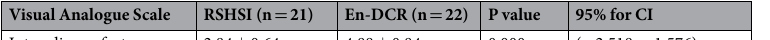
Visual Analogue